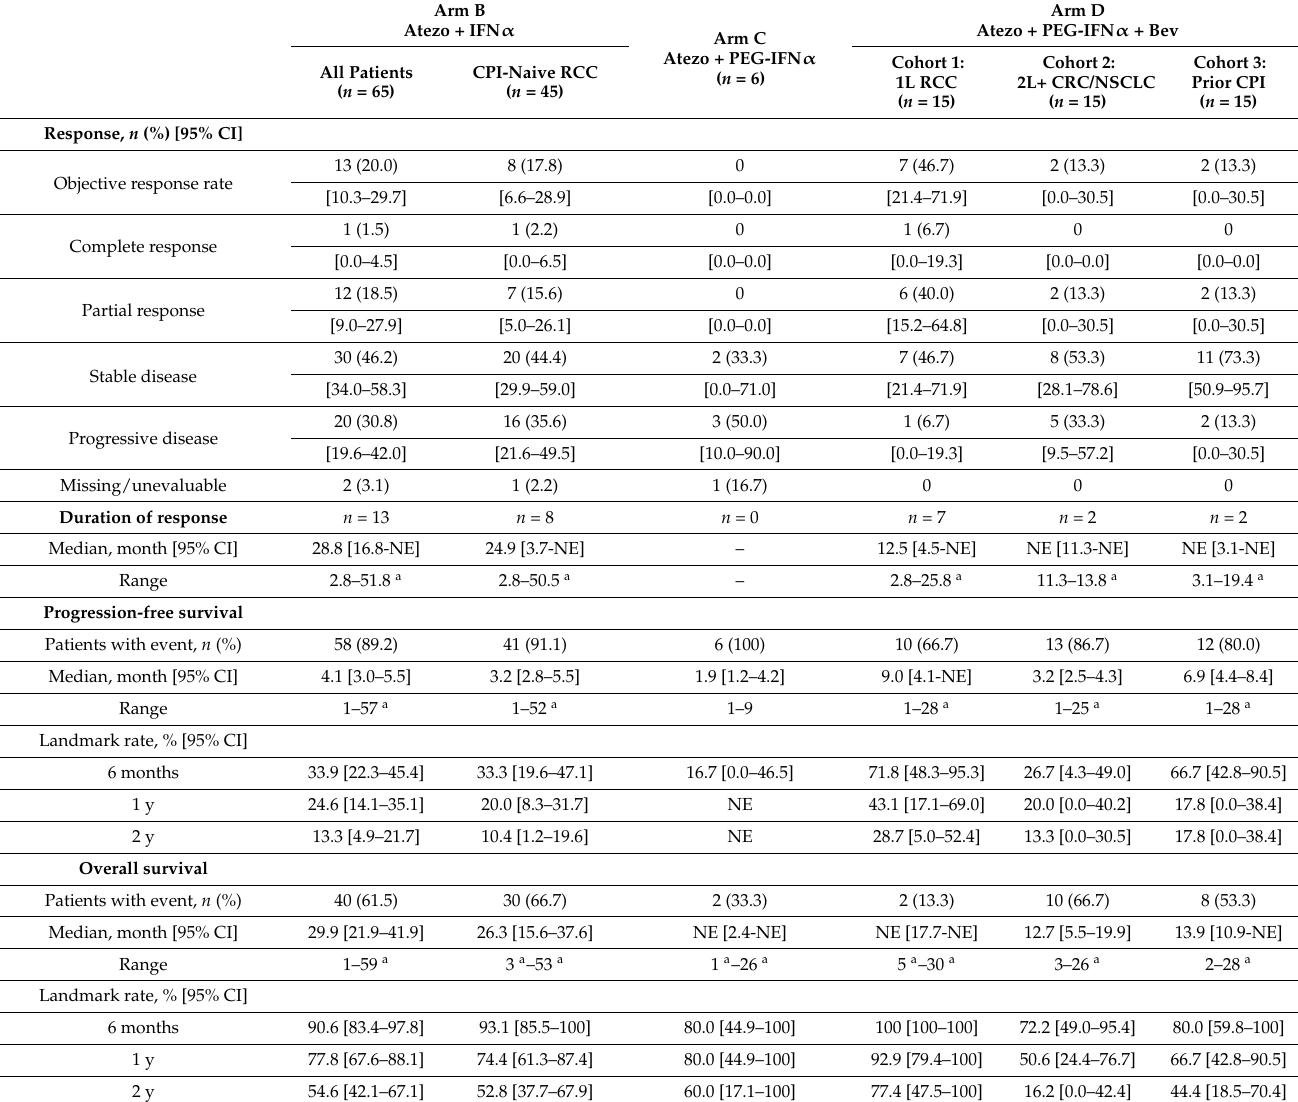
Table 4. Efficacy